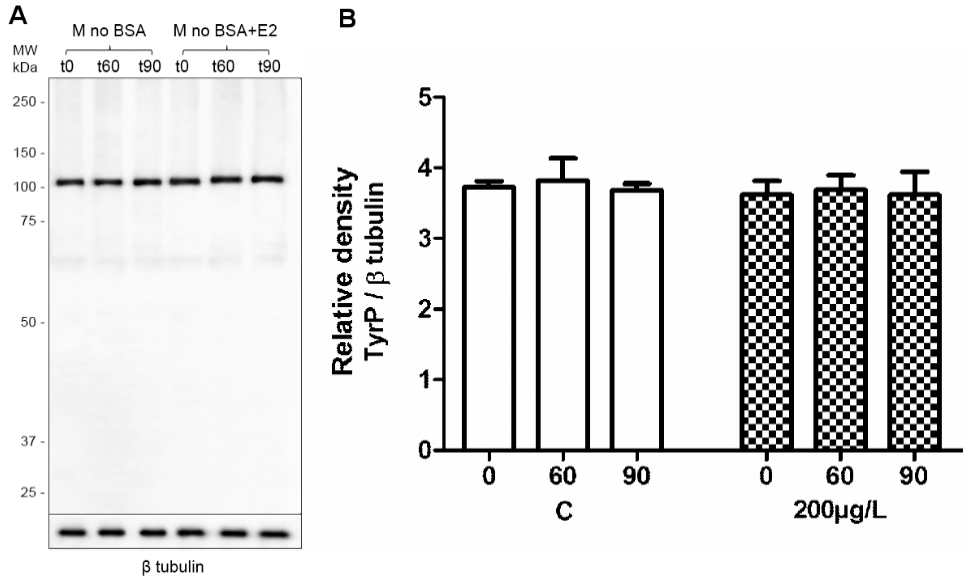
Figure 4. Time-dependent sperm protein TyrP in presence of estradiol (E2) under non-capacitating conditions by Western blot analysis and relative densitometry. ( A ) Control samples: sperm capacitating in commercial M2 medium (M); M + E2: the medium enriched by E2 in different concentrations (2, 20, and 200 µ g/L); M with no BSA; and M with no BSA + E2: sperm left in the medium without BSA or without BSA with the addition of E2 (200 µ g/L) for 60 and 90 min. Increasing protein TyrP was not observed for any time (t60, t90) or experimental conditions. All incubation times and conditions indicate the same patterns that were identical to the non-capacitating sperm pattern (t0). β -tubulin was used as the loading control. The samples contained a protein equivalent of 106